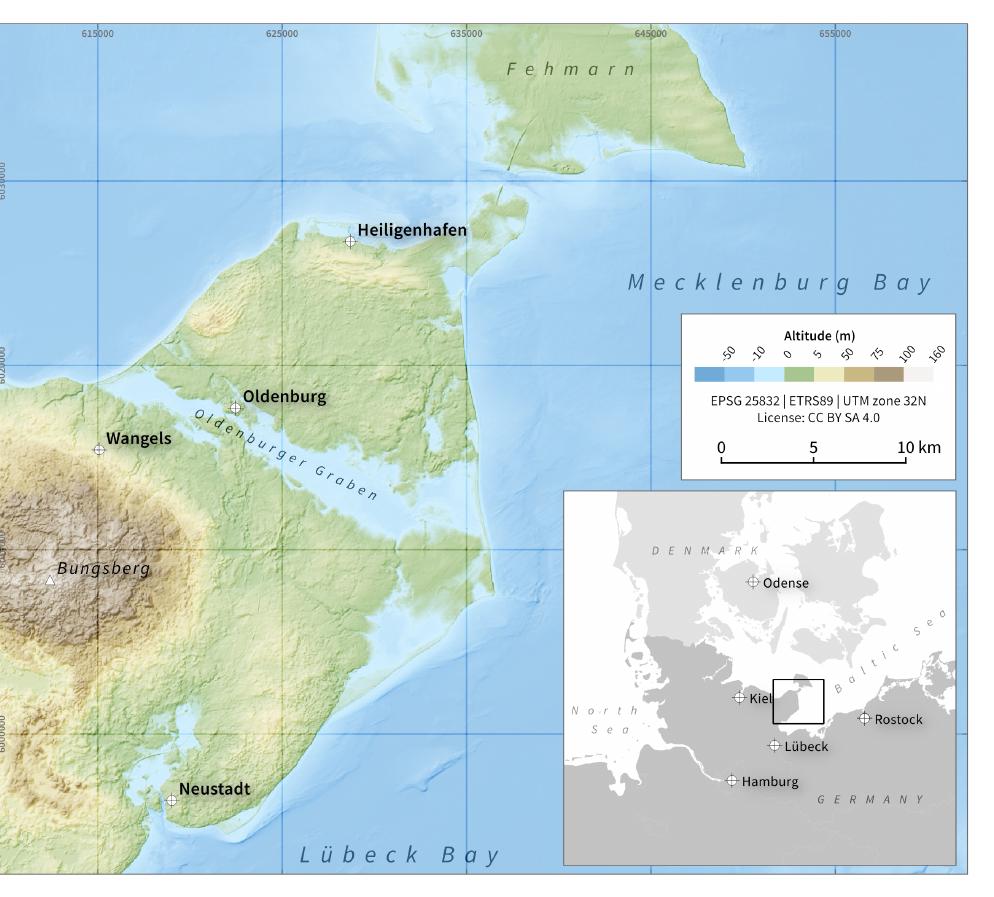
Figure 1. The location of the study area with sites mentioned in the